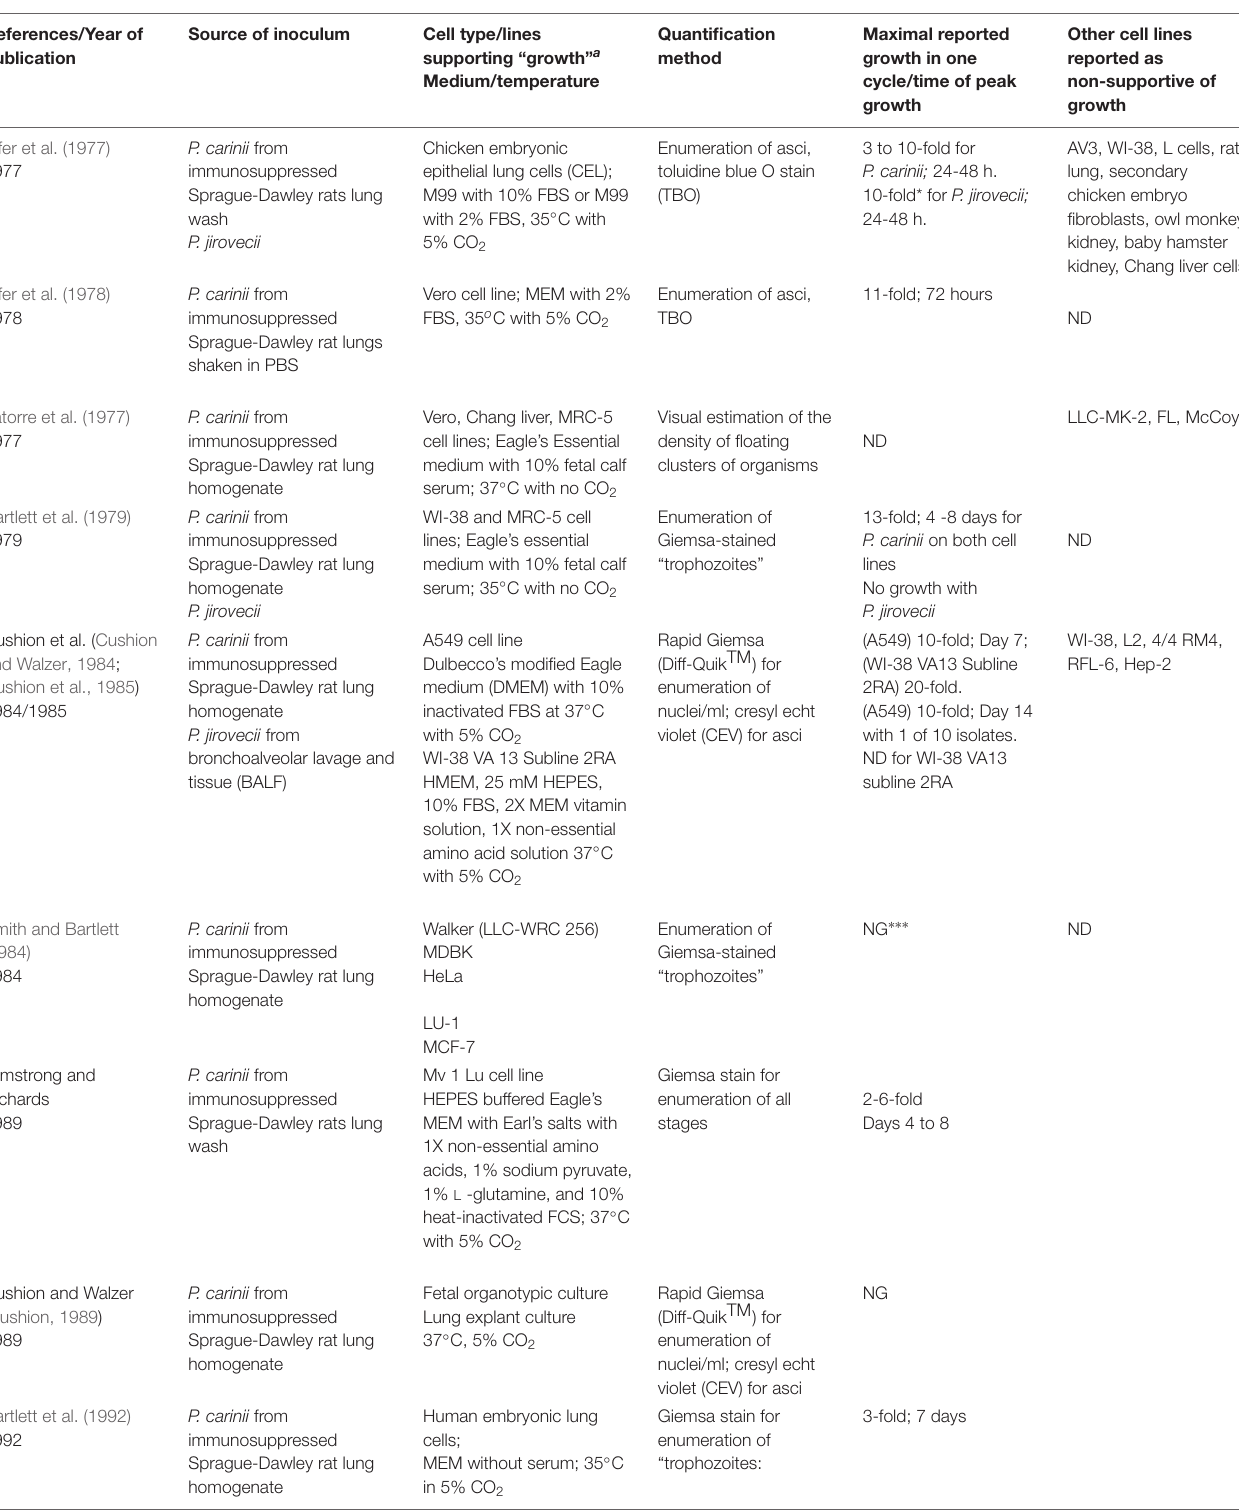
TABLE 1 | In vitro culture of Pneumocystis species with primary and cell